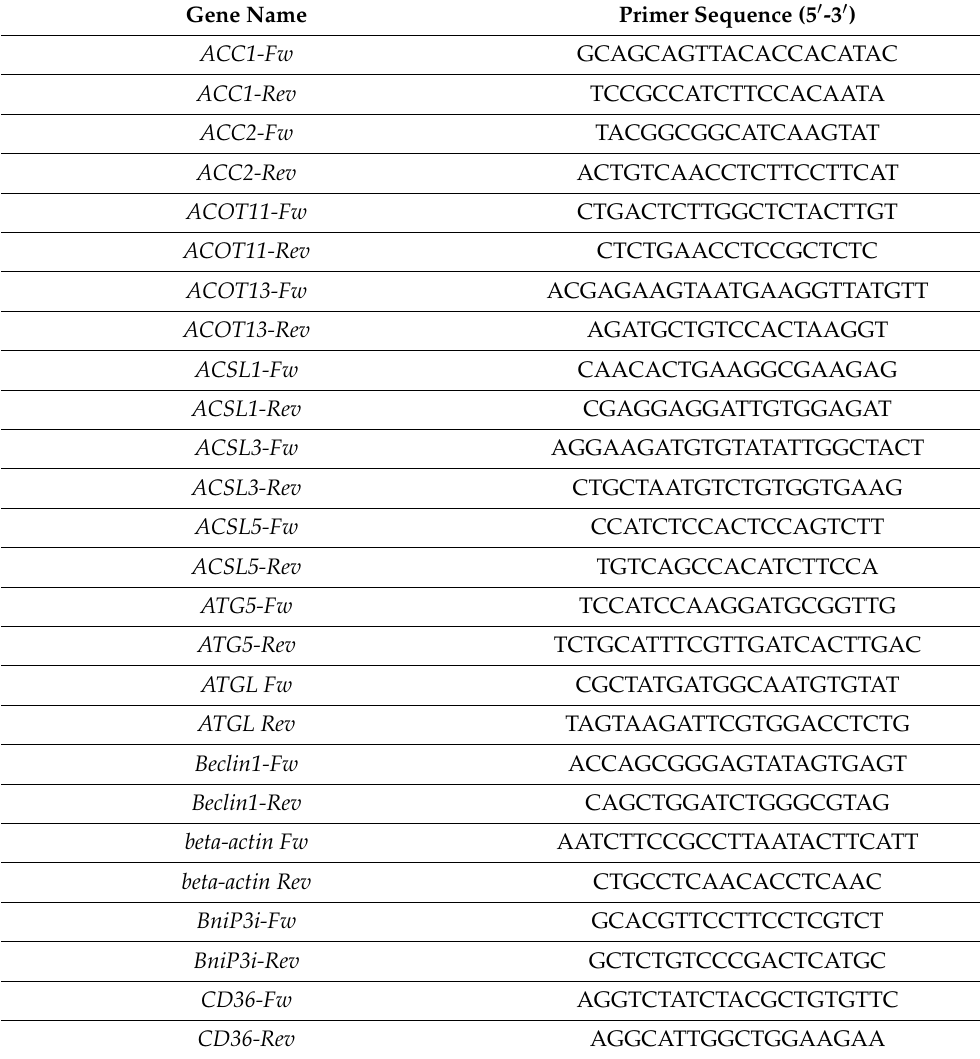
Table 2. Primer sequences for genes used in